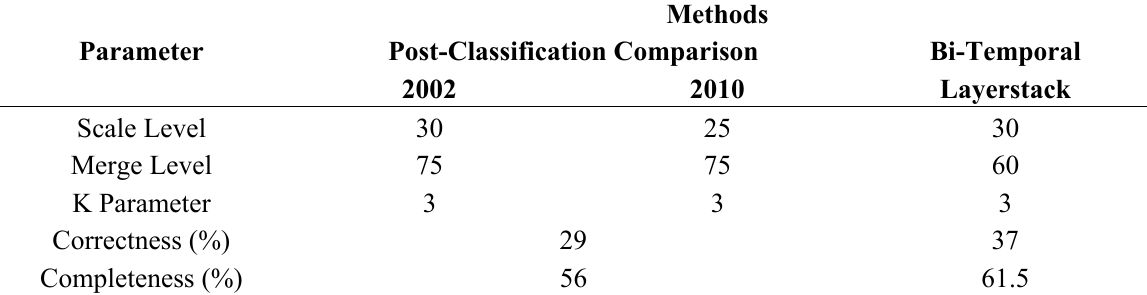
Table 5. ENVI Feature Extraction Approach